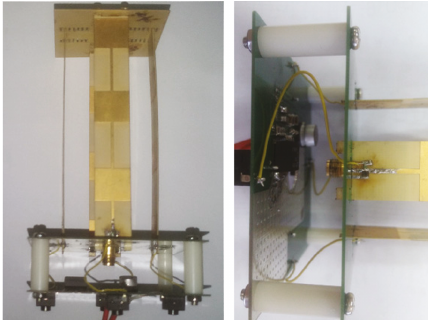
Figure 4: The photograph of the fabrication of the proposed antenna.